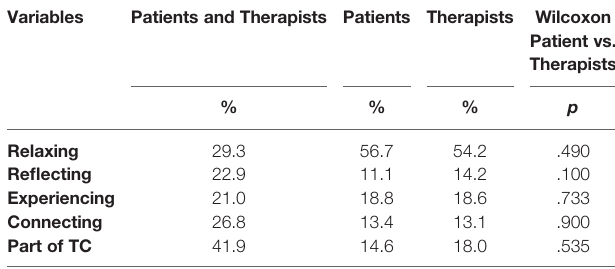
TABLE 2 | TCM patterns in the total text and separately for patients and